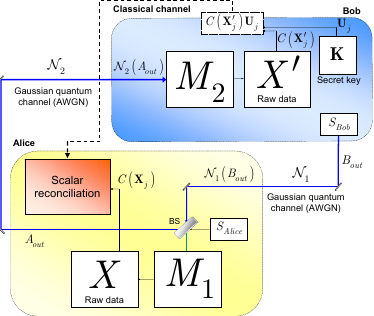
Figure 1. The simplified view of a Prepare-and-Measure (PM)-reverse reconciliation (RR) two-way continuous-variable quantum key distribution (CVQKD) protocol with the scalar reconciliation. The modulated Gaussian variables are sent through a Gaussian quantum channel (AWGN) depicted by 1 and N 2 (same physical link). The classical channel is depicted by the dashed line. Bob sends S Bob to Alice over N 1 . Alice adds to it her secret S Alice by a BS, and applies measurement M 1 , which defines her raw data X = M 1 ( N 1 ( S Bob ) + S Alice ) . The other mode is sent back to Bob over N 2 , who applies M 2 , which results in his X (cid:48) = M 2 ( N 2 ( N 1 ( S Bob ) + S Alice ))